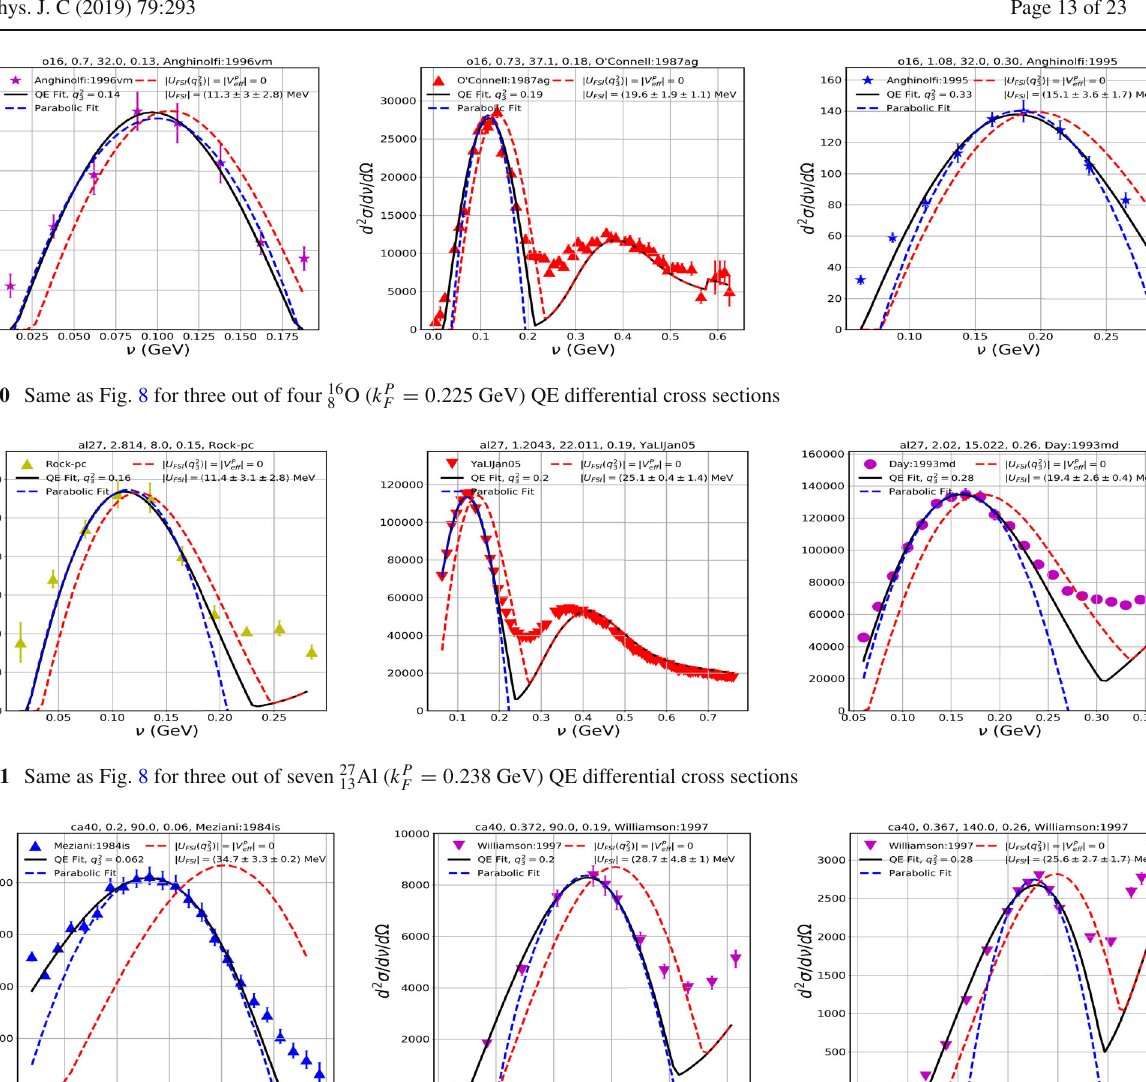
Fig. 12 Same as Fig. 8 for three out of 29 40